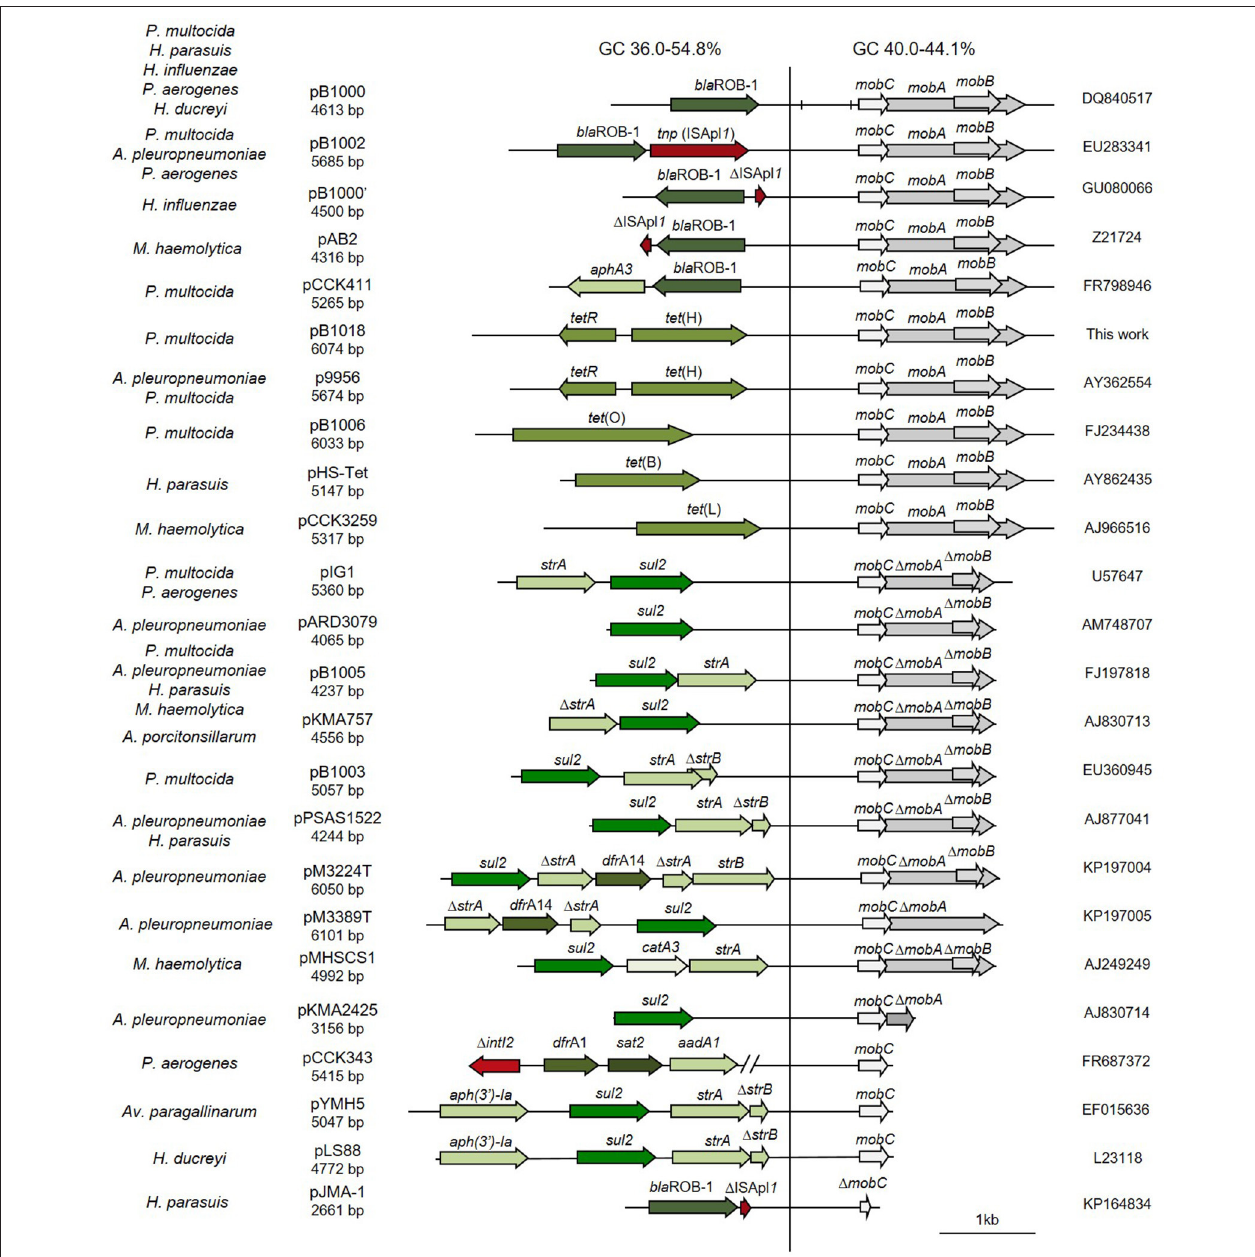
FIGURE 1 | Genetic structure of ColE1 plasmids from Pasteurellaceae. Schematic diagram of ColE1 plasmids from the Pasteurellaceae family. The reading frames for genes are shown as arrows, with the direction of transcription indicated by the arrowhead. Antimicrobial drug resistance determinants are shown in green whereas genes involved in genetic transposition or integration are shown in red. Genes encoding plasmid relaxases are shown in gray. In pB1000, two vertical bars bracket the region containing the putative origin of replication ( oriV ) and the putative origin of transfer ( oriT ). The large vertical bar separates the conserved region of the plasmid, to the right, from the variable region of the plasmid, to the left. Percentage ranges of GC content of variable and conserved regions of the plasmids are indicated in the top of the figure. The species in which the plasmid has been described and the name, size and accession number of plasmids are also